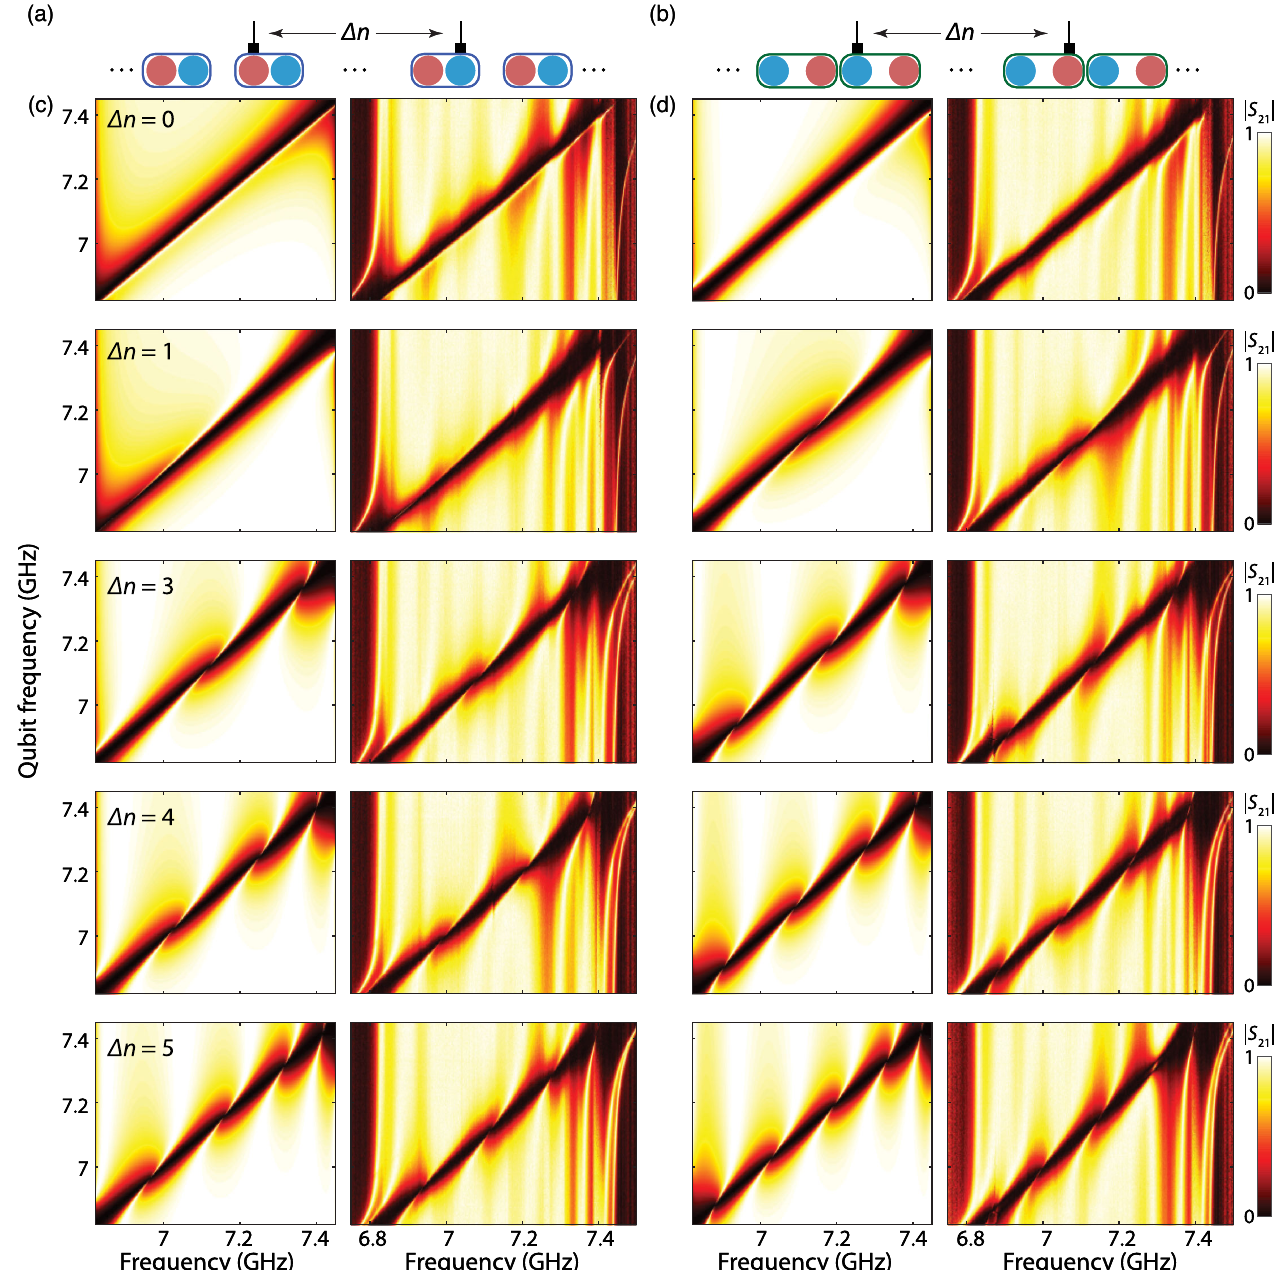
FIG. 15. (a) Schematic showing two qubits separated by Δ n unit cells in the trivial configuration. (b) Corresponding schematic for topological phase configuration. (c) Waveguide transmission spectrum j S 21 j when frequencies of two qubits are resonantly tuned across the upper passband in the trivial configuration. (d) Waveguide transmission spectrum j S 21 j for the topological configuration. For both trivial and topological spectra, the left spectrum illustrates theoretical expectations based on Ref. [29] whereas the right shows the experimental